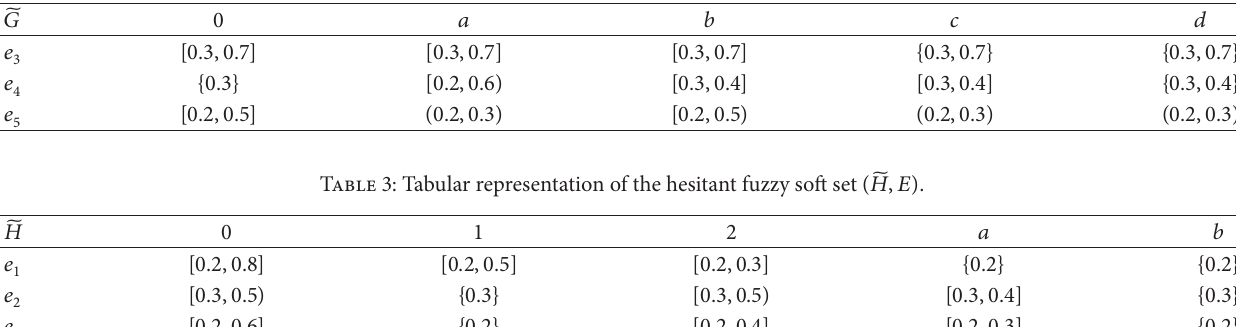
Table 1: Tabular representation of the hesitant fuzzy soft set